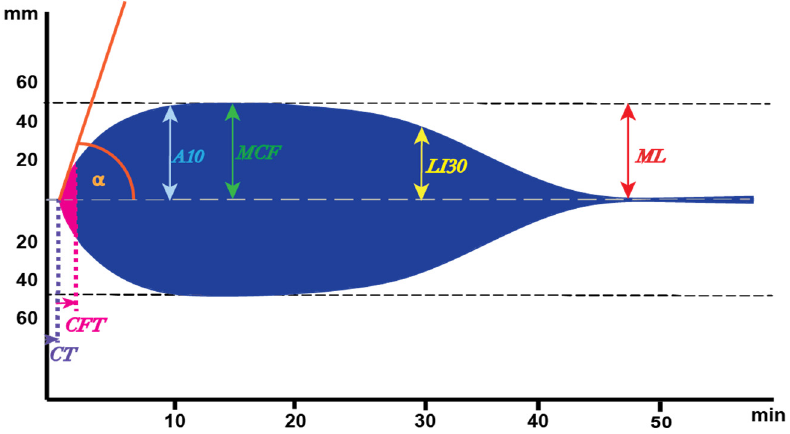
Figure 2. Depiction of a symmetrical ROTEM outcome. Parameters originated from the graph: Clotting time (CT): time until the 2 mm of amplitude is reached; Clot formation time (CFT): time until the amplitude of 20 mm is reached; α -angle: the angle between the baseline and the tangent to the curve via the 2 mm amplitude point; A10: amplitude at 10 min; Maximum clot firmness (MCF): maximum amplitude; LI30: clot lysis index at 30 min; ML: maximum lysis.